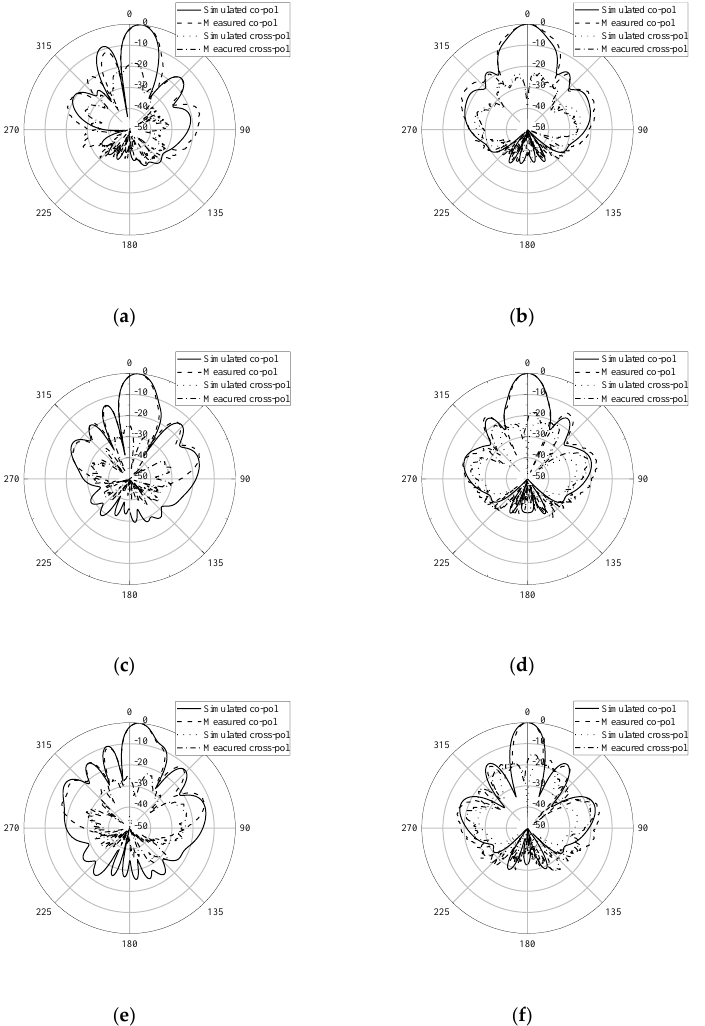
Figure 13. Simulated and measured radiation patterns ( a ) at 27 GHz in the E plane, ( b ) at 27 GHz in the H plane, ( c ) at 28 GHz in the E plane, ( d ) at 28 GHz in the H plane, ( e ) at 29 GHz in the E plane, and ( f ) at 29 GHz in the H plane. Table 2. Comparison of the proposed 5 × 5 interconnected ME dipole antenna array with related published works.